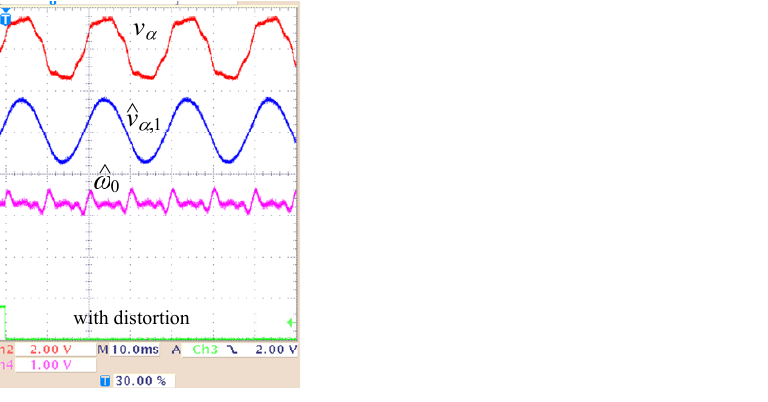
Figure 8. Transient response of the SRF-based PLL at f 0 = 50 Hz after going from a pure sinusoidal to a distorted reference of: (from top to bottom) v α ( y -axis: 200 V/div), ˆ v α ,1 ( y -axis: 200 V/div), ˆ ω 0 ( y -axis: 97.66 rad/s/div) and enabling signal ( x -axis: 10 ms/div in all signals).